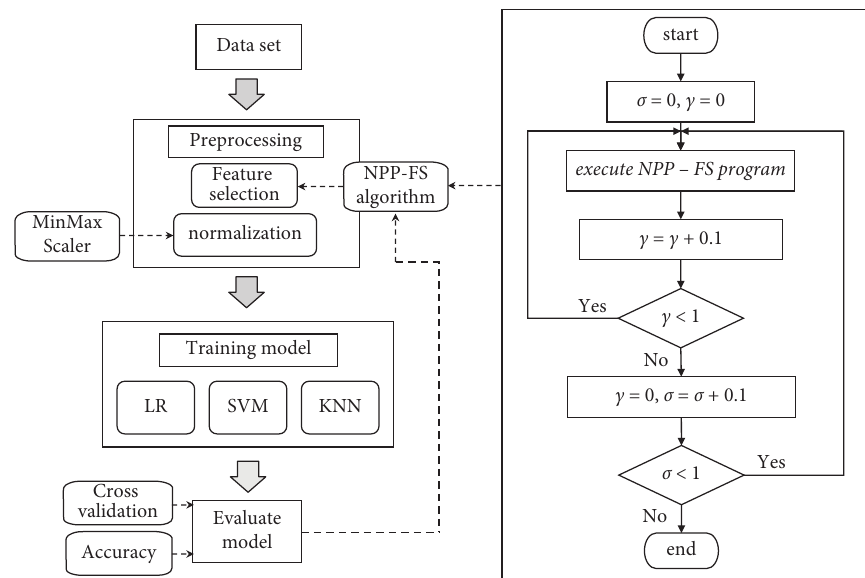
Figure 6: Program of sensitivity analysis experiment. Table 3: Sensitivity analysis experiment data.